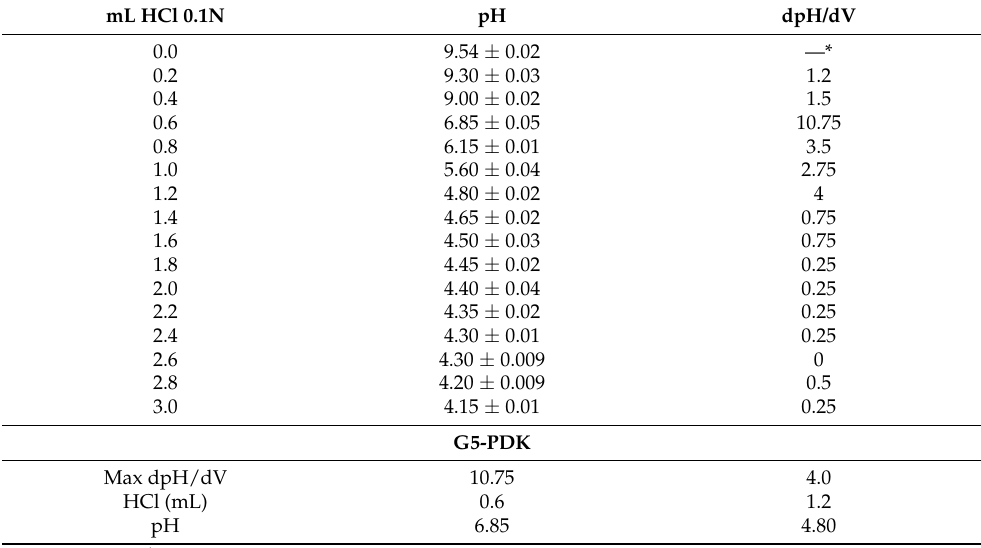
Table 2. Data of potentiometric titration used for constructing the titration curve and those of dpH/dV used for constructing the first derivative